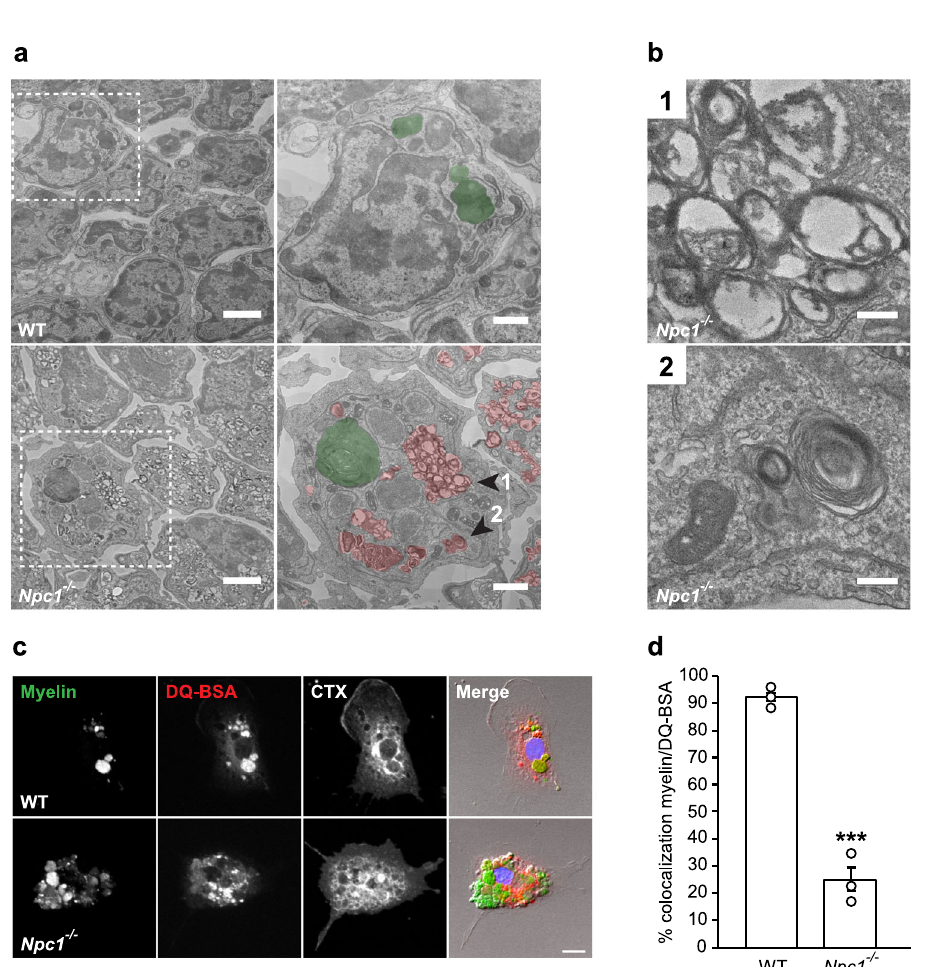
Fig. 6 Myelin accumulation in late endosomes/MVBs of Npc1 − / − microglia. a EM analysis of microglia acutely isolated from pre-symptomatic WT and Npc1 − / − mice from three independent experiments ( n = 3) shows the signi fi cant intracytoplasmic accumulation of MVBs in Npc1 − / − cells. Boxed regions are depicted at higher magni fi cation in right panels (MVBs and lysosomes are pseudocolored in red and green, respectively). Scale bars: 2 μ m (left panels) and 1 μ m (right panels). b Representative high magni fi cation images of Npc1 − / − cell shown in ( a ) (arrowheads 1 and 2) revealing accumulation of MVBs (1). Undigested lipid material (lamellar structures) could be detected within MVBs (2). Scale bars: 0.2 μ m. c Transport of phagocytosed myelin (green) was followed over 1 h in P7 WT and Npc1 − / − microglia from three independent experiments ( n = 3) using DQ-BSA to visualize lysosomal compartments (red) and fl uorescently labeled cholera toxin (CTX, white) to visualize endocytic vesicles. Scale bar: 10 μ m. d Quanti fi cation of the in vitro myelin transport assay shows that, in contrast to WT control, phagocytosed myelin did not reach lysosomal compartments in Npc1 − / − microglia. Values are expressed as percentages of myelin signal colocalizing with DQ-BSA positive lysosomes and represent mean ± SEM from three independent experiments ( n = 3, p = 0.0003, unpaired two-tailed Student ’ s t